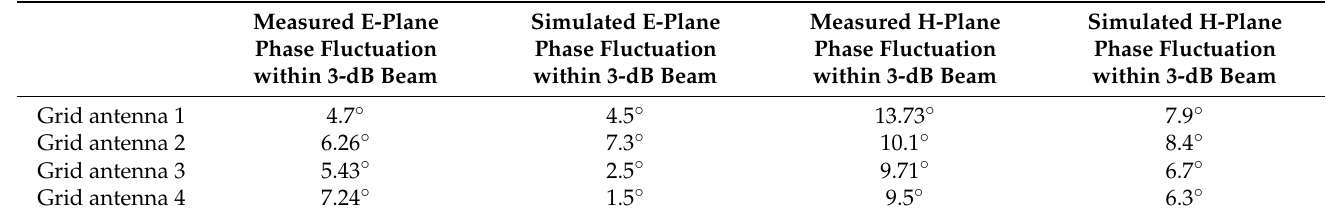
Figure 28. ( a ) Measured E-plane phase pattern of 3-dB beamwidth at the phase center for every antenna element in sparse array; ( b ) measured H-plane phase pattern of 3-dB beamwidth at the phase center for every antenna element in sparse array; ( c ) the phase difference of the remaining grid antennas relative to antenna 1, with the antenna beam pointing in the maximum radiation direction. Table 8. Measured and simulated E- and H-plane phase fluctuations within 3-dB beamwidth of every antenna element in the sparse array.